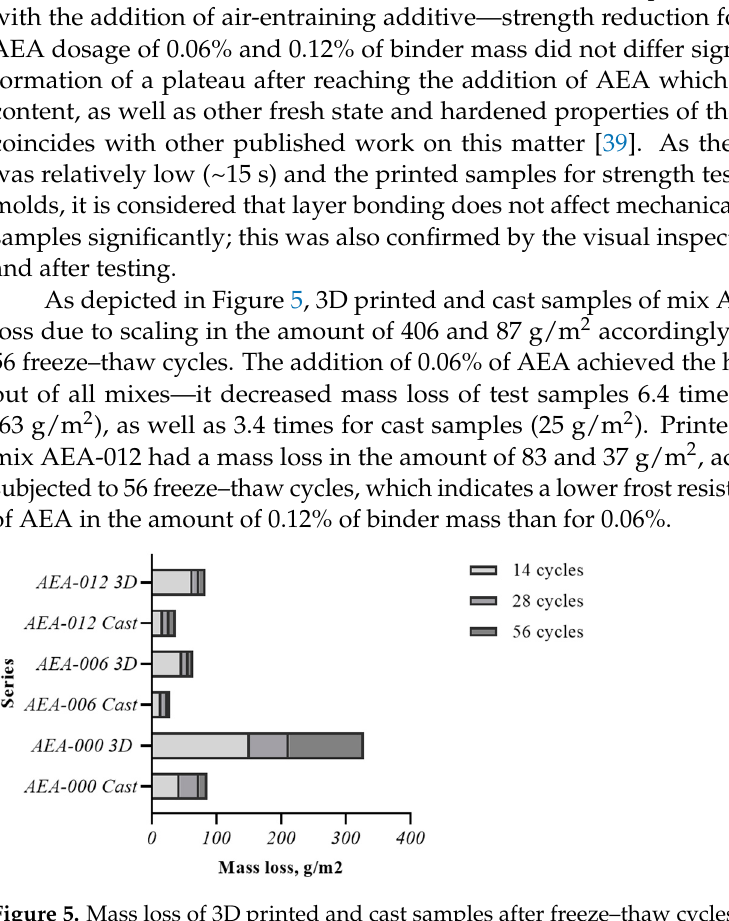
Figure 5. Mass loss of 3D printed and cast samples after freeze–thaw cycles.